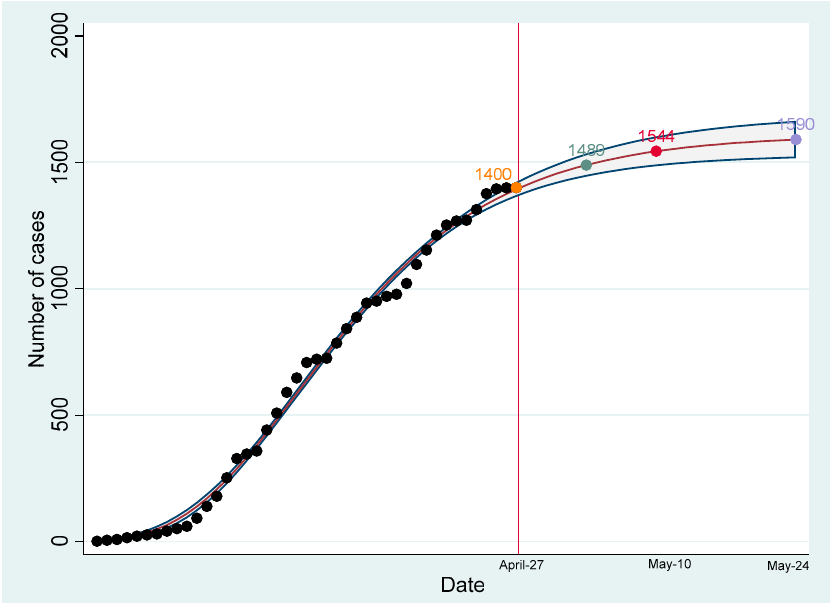
Figure 4. Daily confirmed COVID-19 cases in Puerto Rico as of 27 April 2020 and predictions according to Gompertz model.